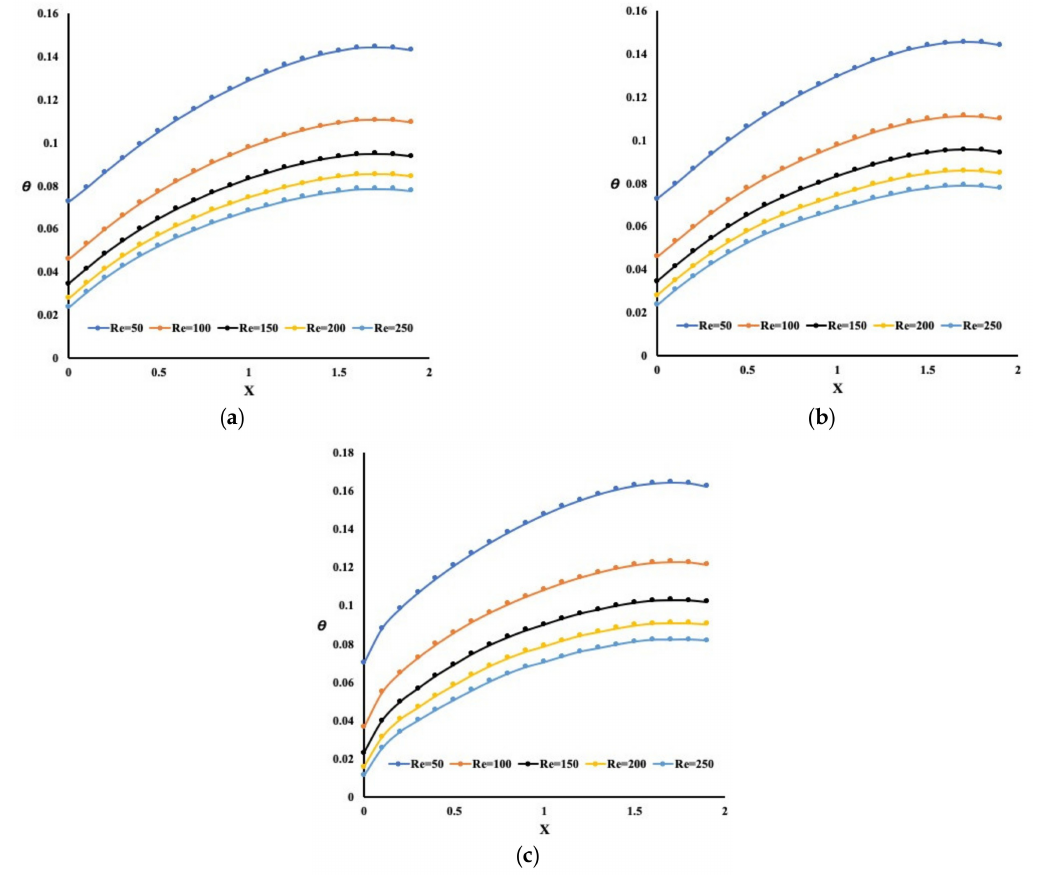
Figure 3. Temperature variation for different configurations (6 mm pin-fins height case, ( a ) Straight pin-fins configuration, ( b ) Wavy pin-fins configuration, ( c ) No pin-fins configuration).